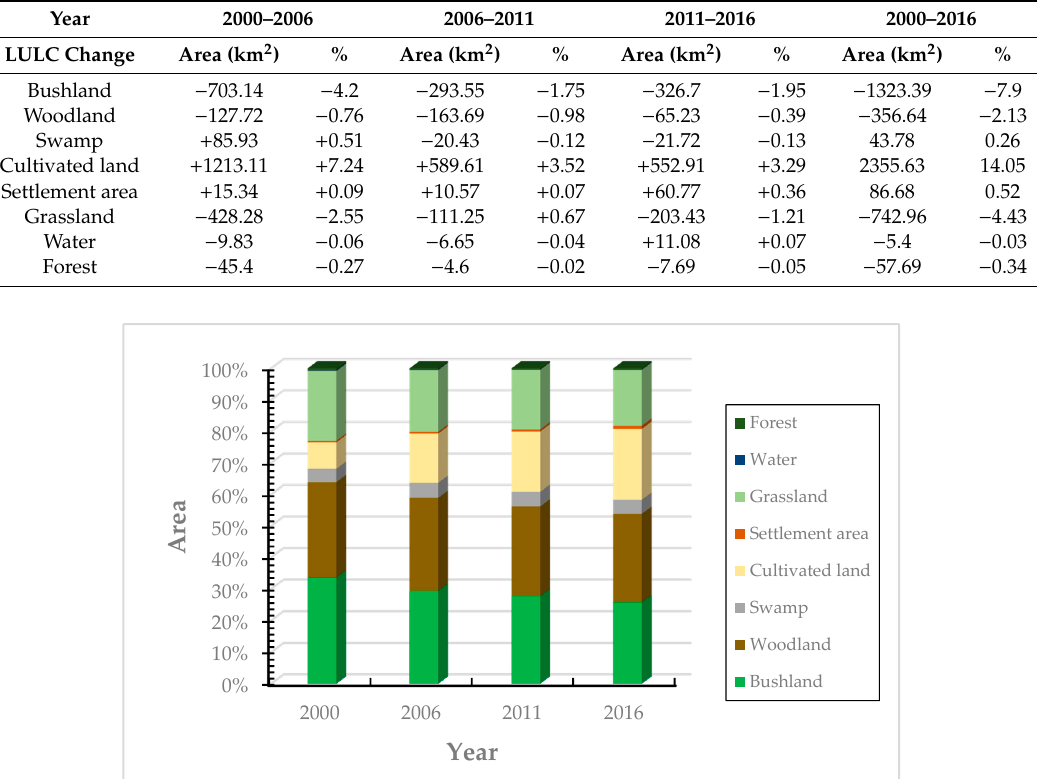
Table 5. Results of the LULC classification for 2000, 2006, 2011, and 2016 images showing the area of each category and category percentages (Kinyasungwe Sub-catchment). Table 6. Results of the LULC classification for 2000, 2006, 2011, and 2016 images showing the area changed and percentage at Kinyasungwe Sub-catchment.